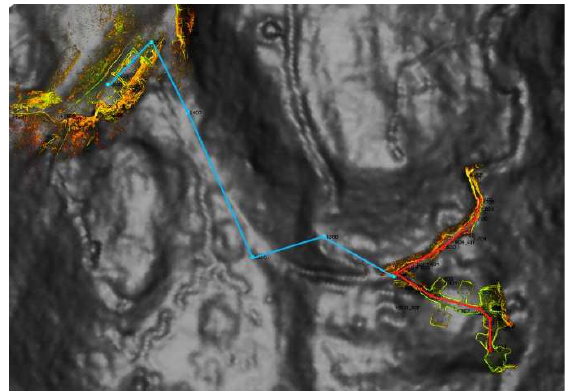
Figure 4. Top view of the Nagià Grom site: the scheme of the topographic (blue line) and laser-scanner surveys (coloured point clouds) on the ALS DTM.